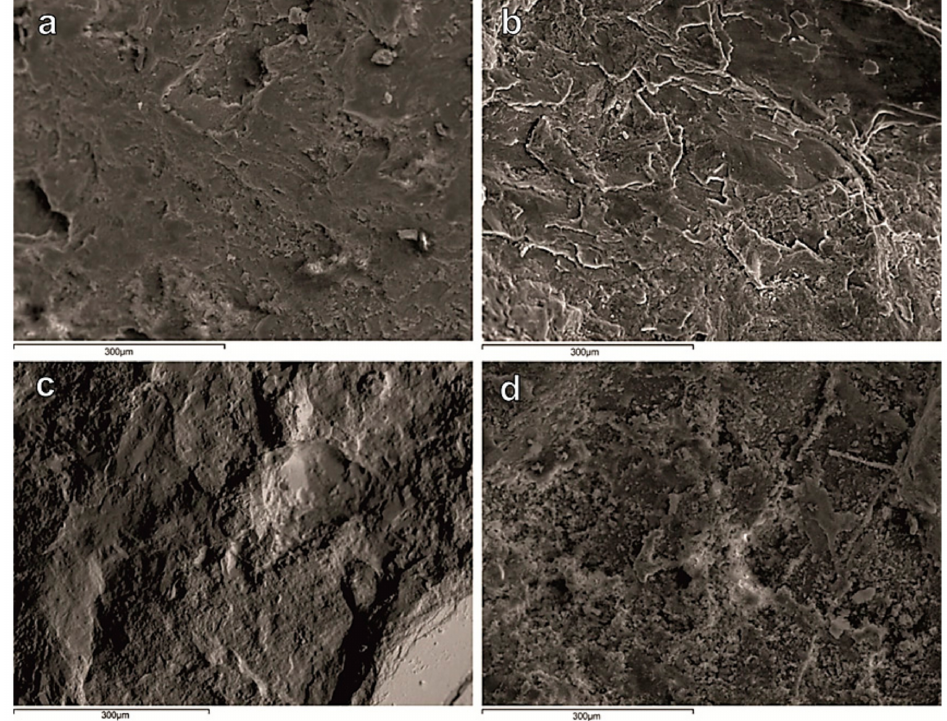
Figure 6. Back scattered electron images showing the surface texture from representative serpentinites ( a : sample BE.133 and b : sample BE.103) and andesites ( c : sample BE.82 and d : sample